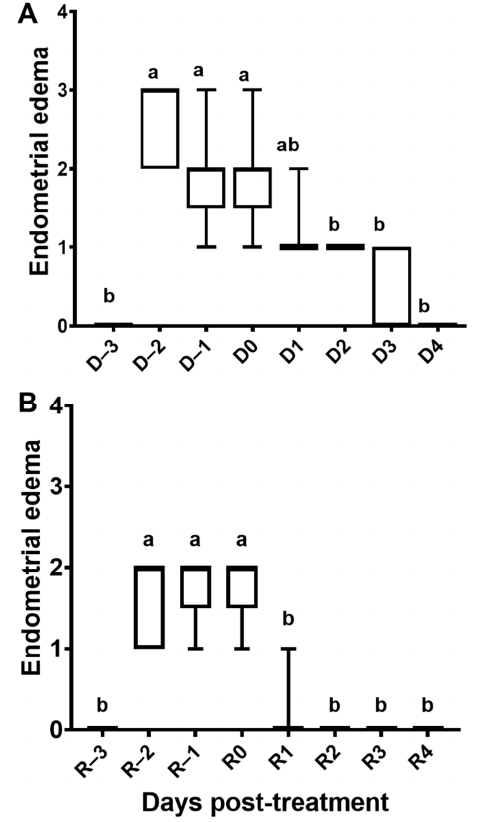
Figure 4. Endometrial edema scores of acyclic mares (n = 12) synchronized with estradiol and intravaginal progesterone release device (IPRD). ( A ) Mares treated with estradiol-17 β for 3 days (D–3